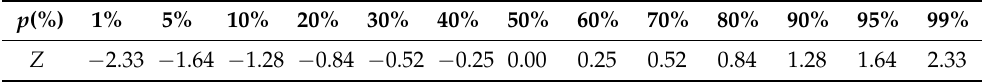
Table 1. Z -score in the cumulative normal